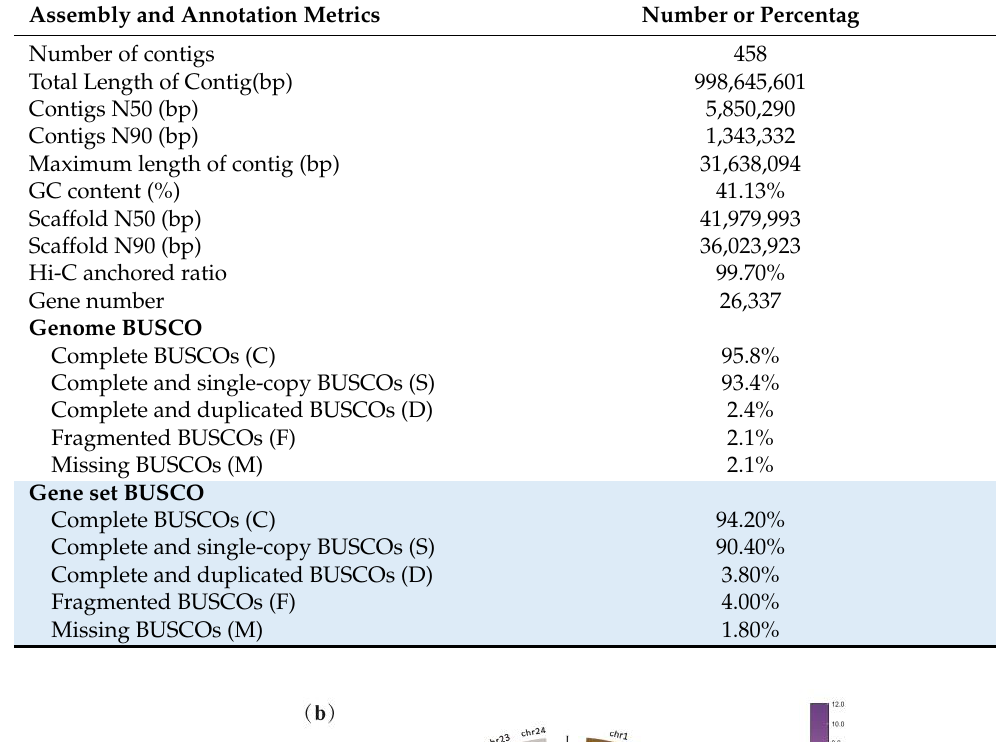
Table 1. The statistics of the Epinephelus cyanopodus genome assembly and annotation.